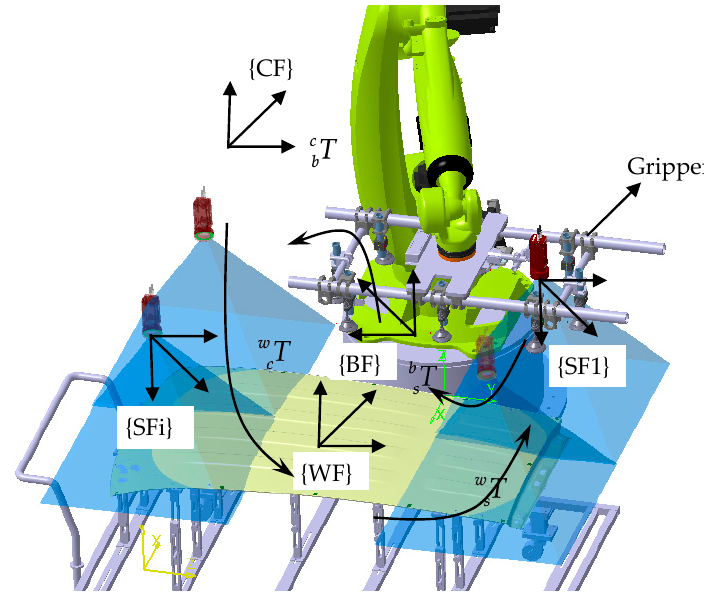
Figure 1. Schematic of robot intelligent grasping system.